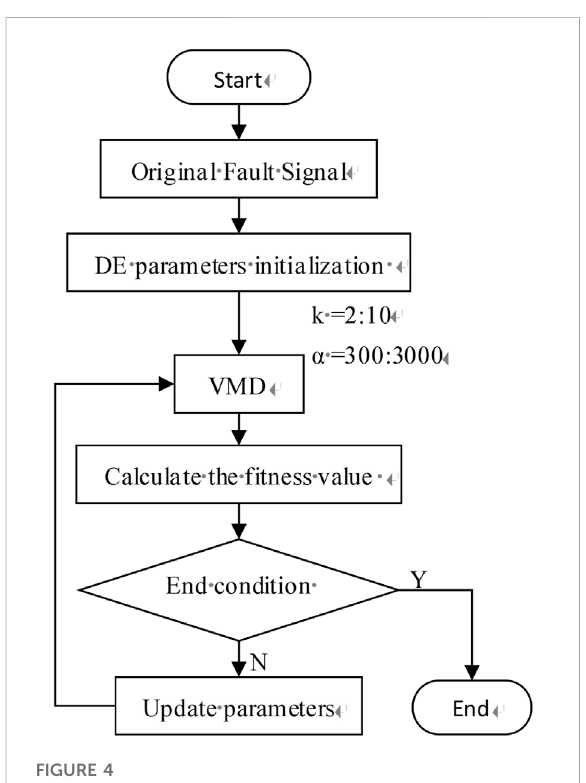
FIGURE 4 The algorithm fl ow of the VMD optimized by the DE.